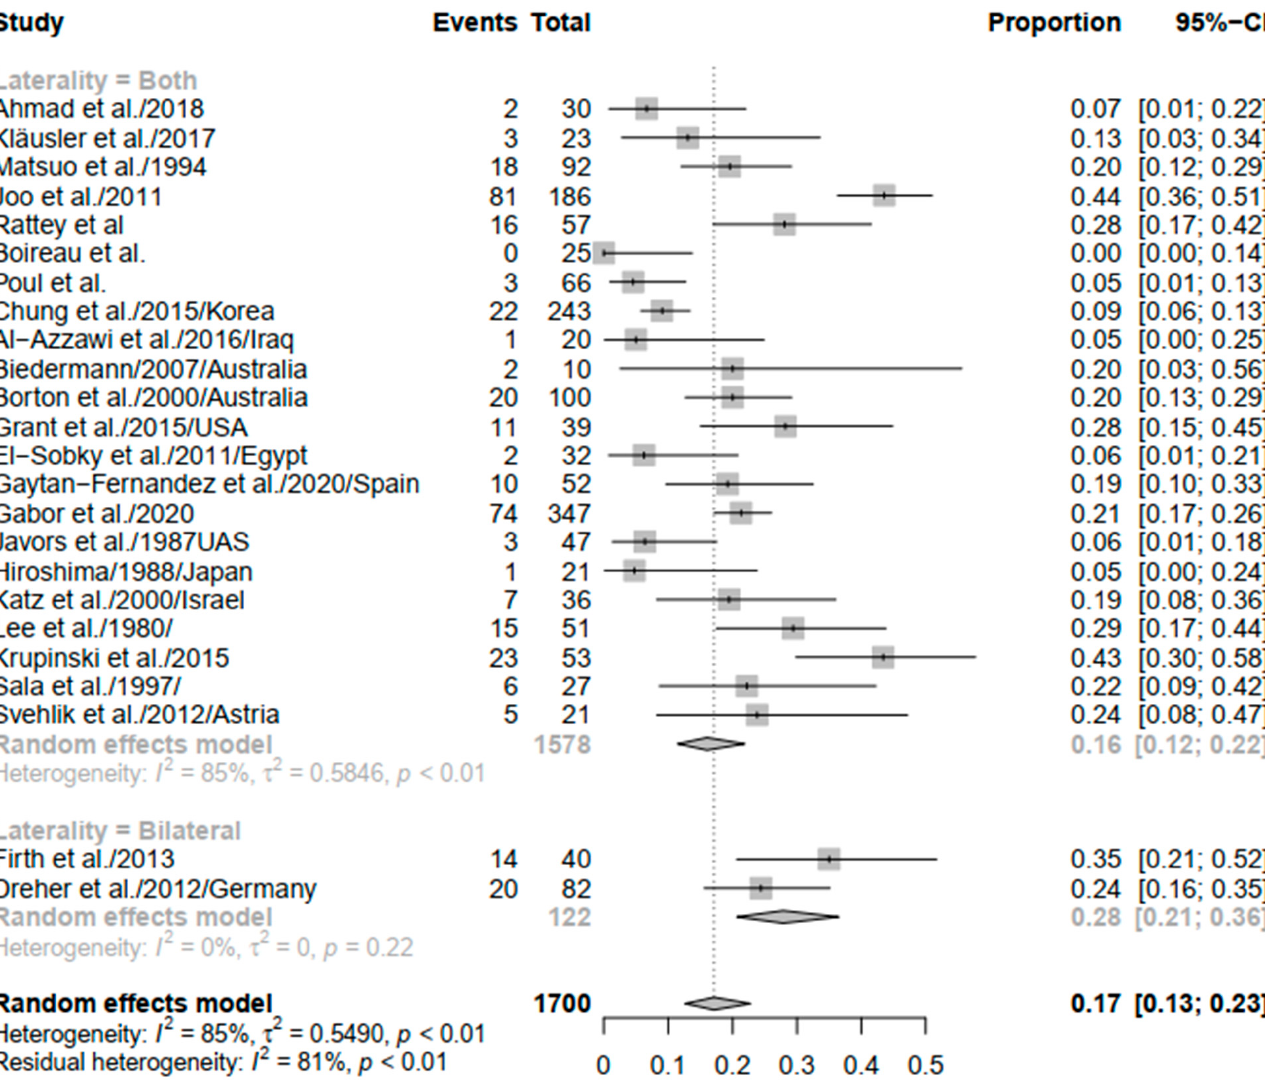
Figure 3. Forest plot of subgroup analysis of equinus recurrence based on the laterality of CP.